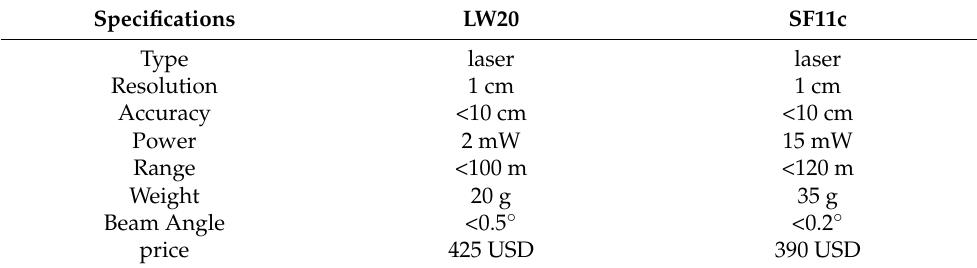
Figure 5. Changes in altitude recorded by altimeters in a dusty environment. Table 1. Specifications of the tested laser altimeters. Table 1. Specifications of the tested laser